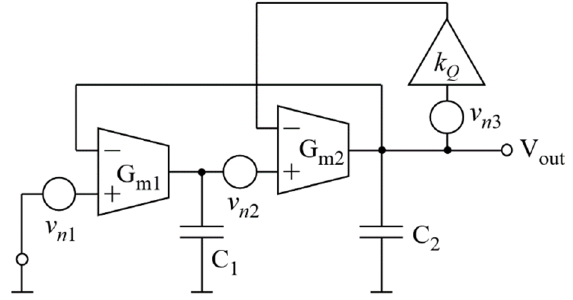
Figure 3. Schematic for noise analysis.